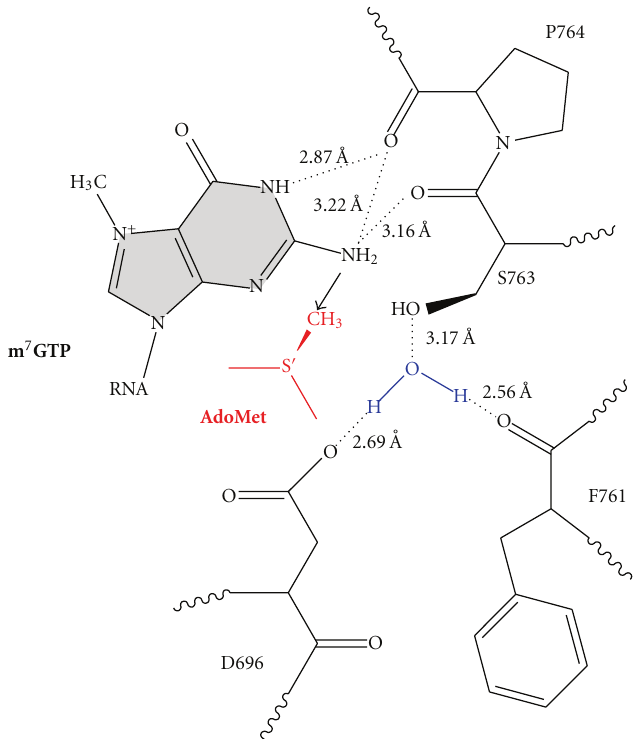
Figure 35: The active site of hTgs1 [90]. Proposed mechanism of methyltransferase activity of hTgs1 is shown. The AdoMet methyl group is in close proximity to N2 position of m 7 GTP. The prerequisite as a substrate for hTgs1 is m 7 G